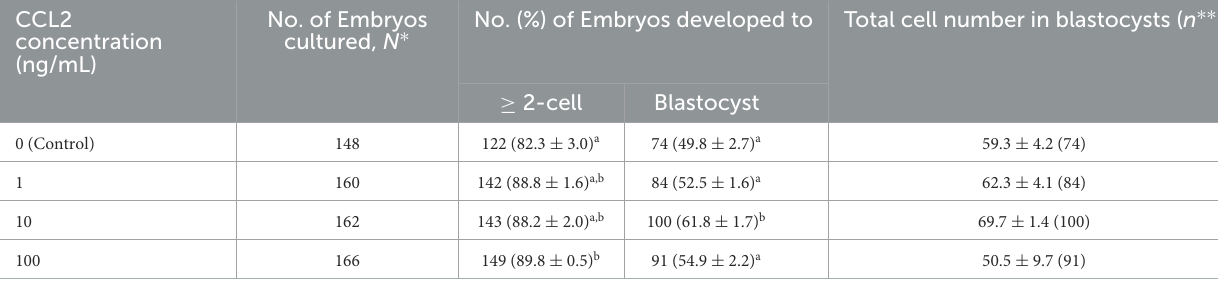
TABLE 3 Effect of CCL2 supplementation during IVM on embryonic developmental potential after PA. CCL2